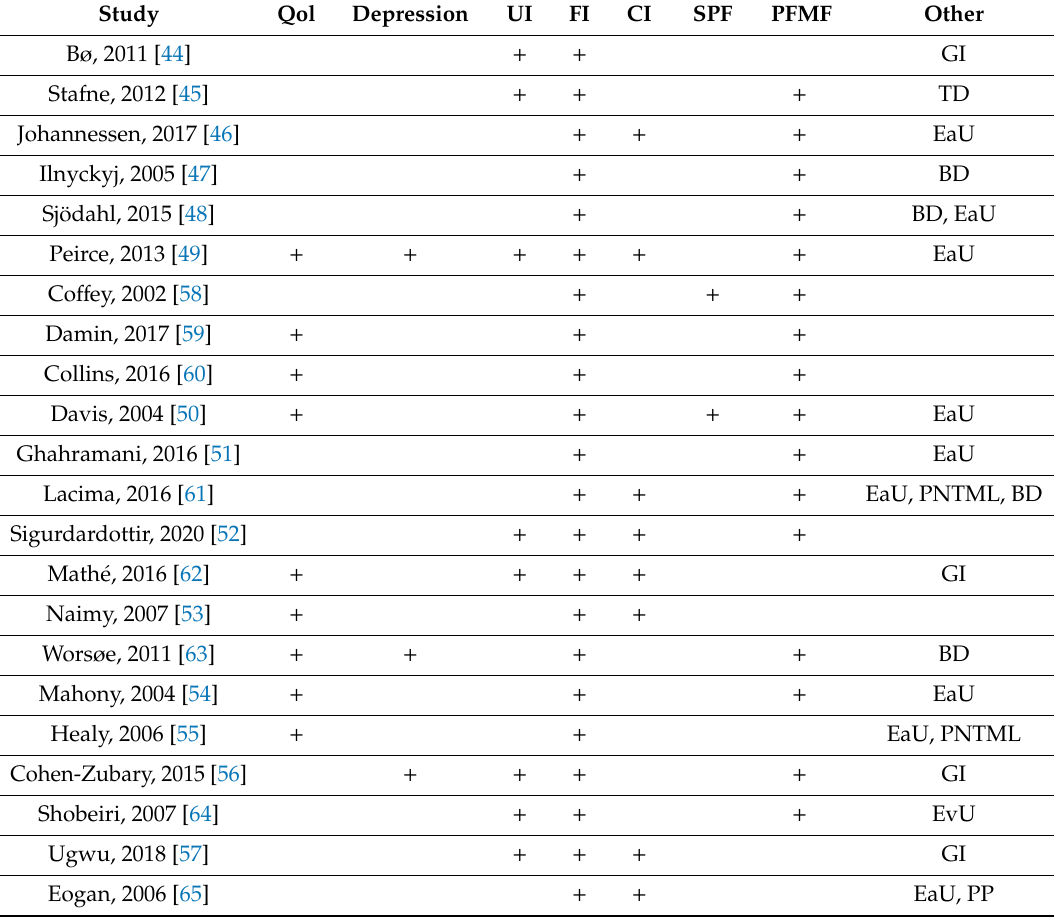
Table 3. Characteristics of comparators of studies qualified for the